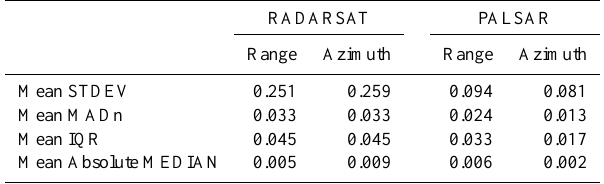
Table 1. Statistics describing the 2-D distribution of measured ground displacements in ice-free terrain (units in md − 1 ) . The STDEV, MADn IQR, and absolute median are calculated for all stable-ground offsets within each image pair. Subsequently, the mean STDEV, MADn, IQR and mean are calculated for all image pairs. RADARSAT PALSAR Range Azimuth